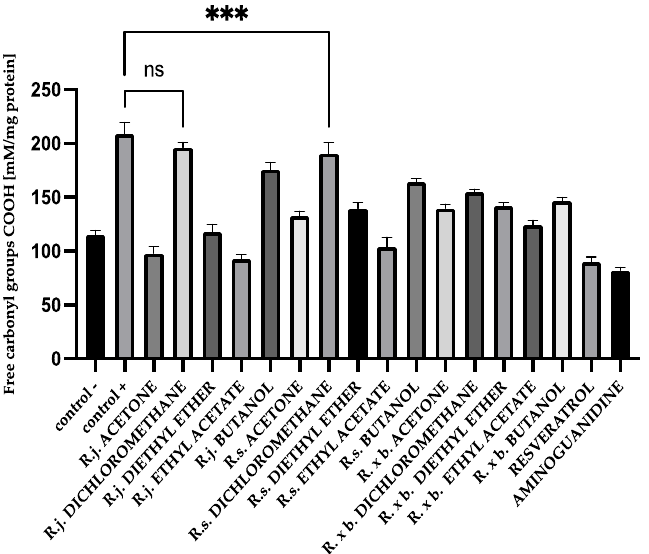
Figure 6. The effect of extracts and fractions on the in vitro formation of COOH groups in BSA glycation. R.j., R.s., and R. × b. mean Reynoutria japonica , Reynoutria sachalinensis , and Reynoutria × bohemica , respectively. Error bars shown in this figure are means ± SD for n ≥ 5. *** Statistically significant at p ≤ 0.001 compared to control +; ns—not statistically significant at p ≤ 0.05. All other results are statistically significant at p ≤ 0.0001 compared to control +. Detailed information can be found in the Supplementary Material. For HSA protein, there was a similar trend among the extracts and fractions. R. japonica showed slightly stronger activity of extracts and for the most active fractions: ethyl acetate and diethyl ether. The results are shown in Figure 7.